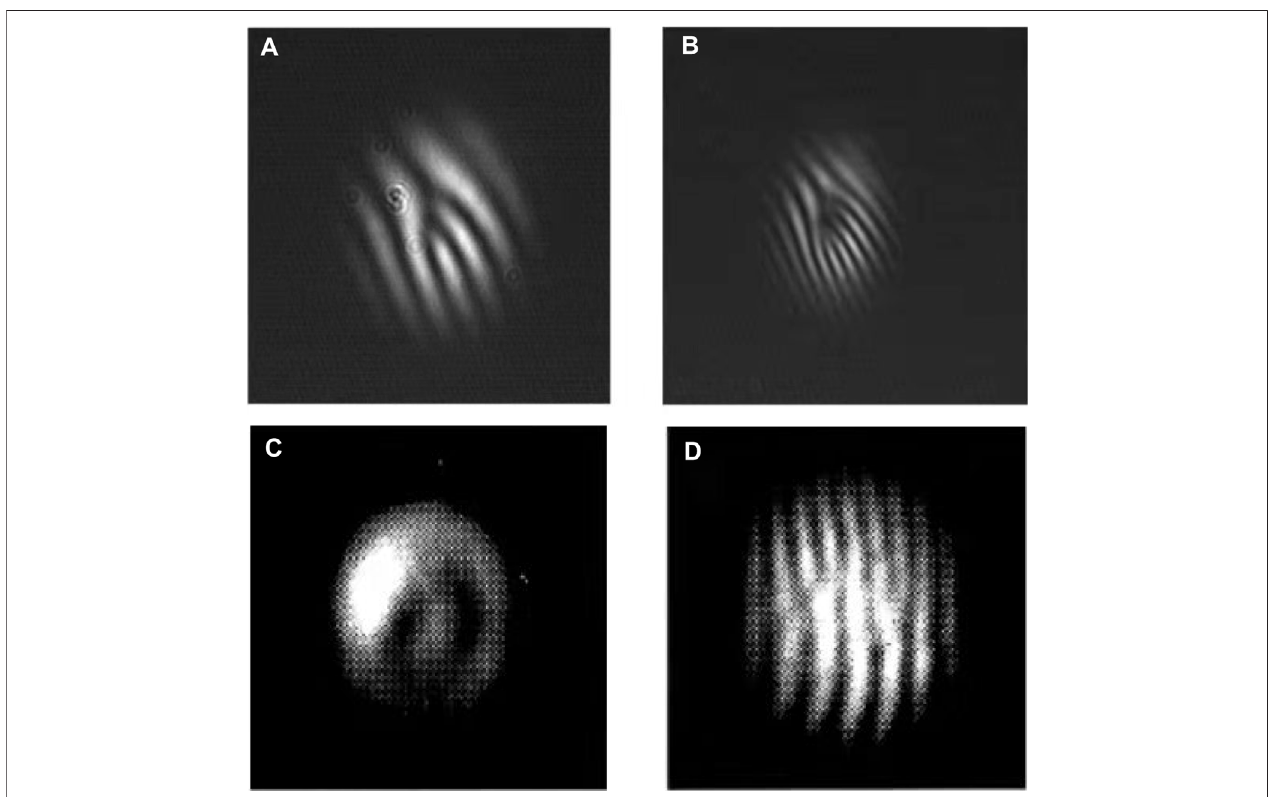
FIGURE4| Forkedinterference fringes[99]of (A) fundamentalwave (B) SHGwave;and (C) Spatialdistributionandinterferencepatterns (D) oftheSHGwavewith the in fl uence of walk-off [100].